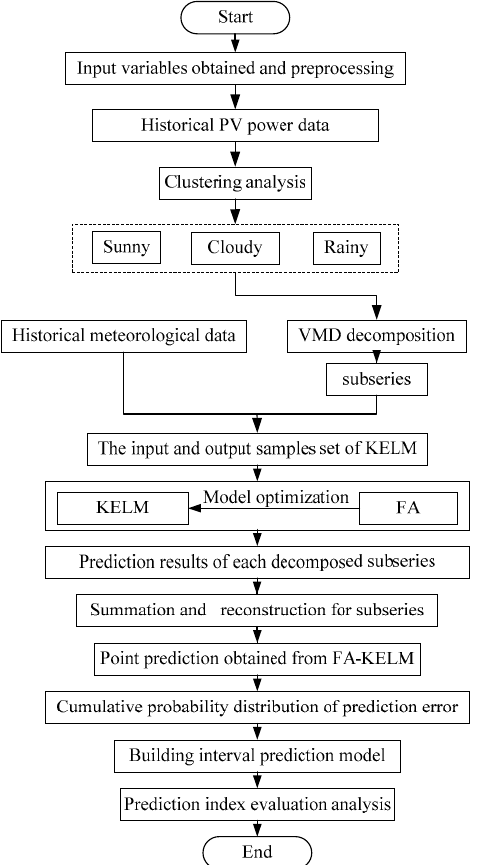
Figure 2. The structure of the proposed prediction model.